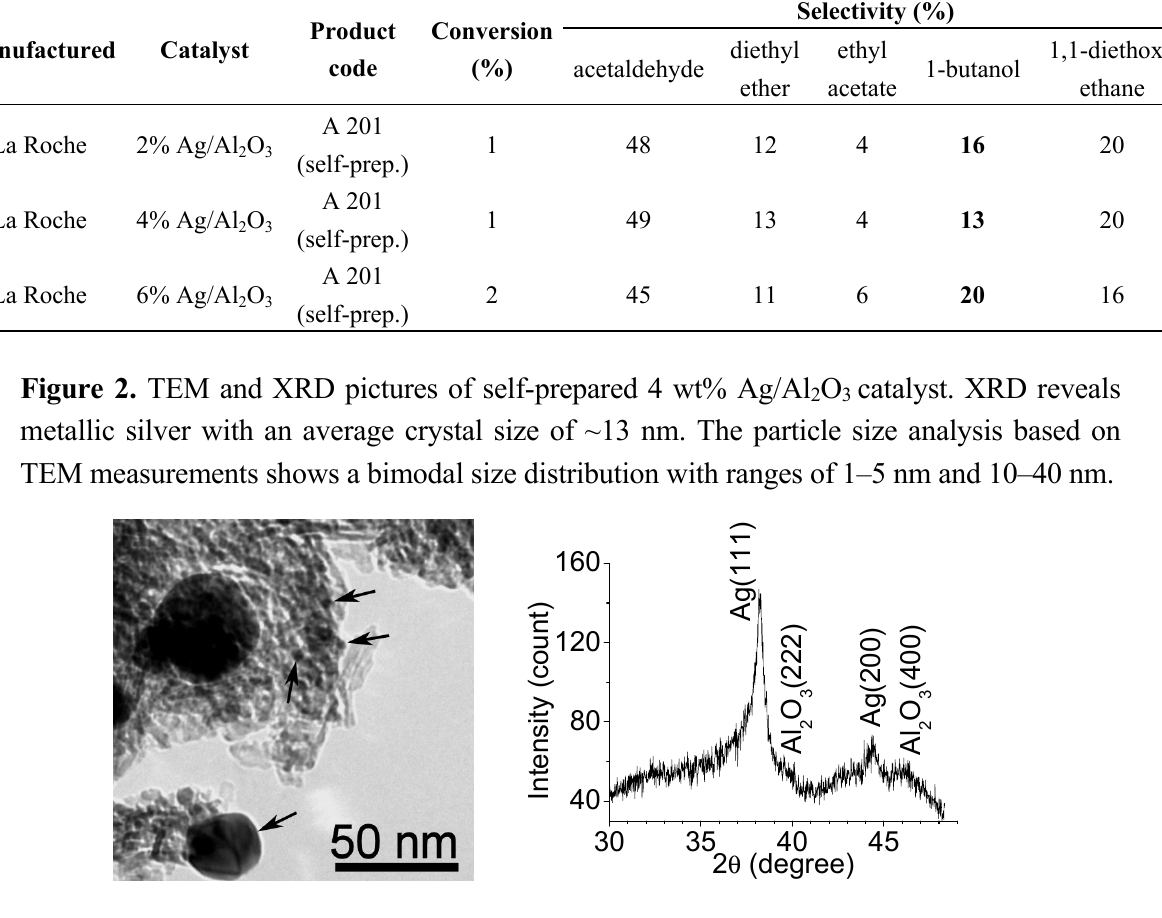
Table 7. Results obtained with alumina supported Ag catalysts.